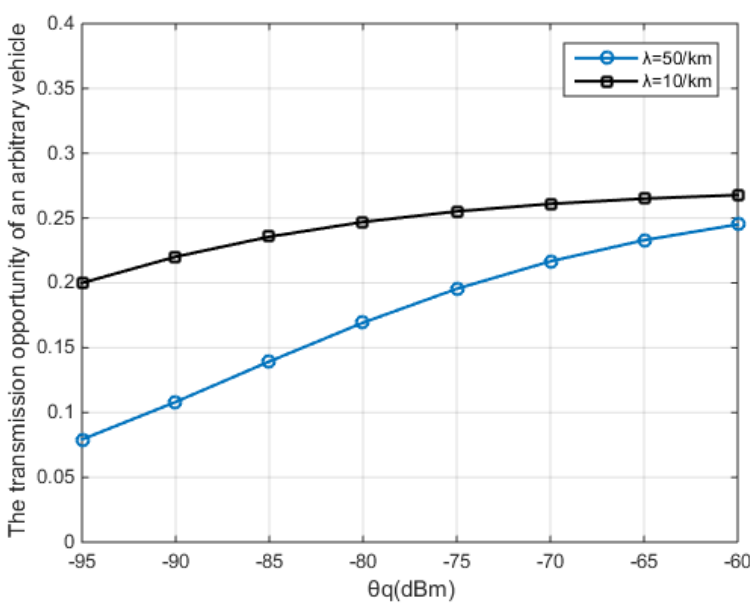
Figure 8. The transmission opportunity with highest priority versus maximum received beacon power threshold.